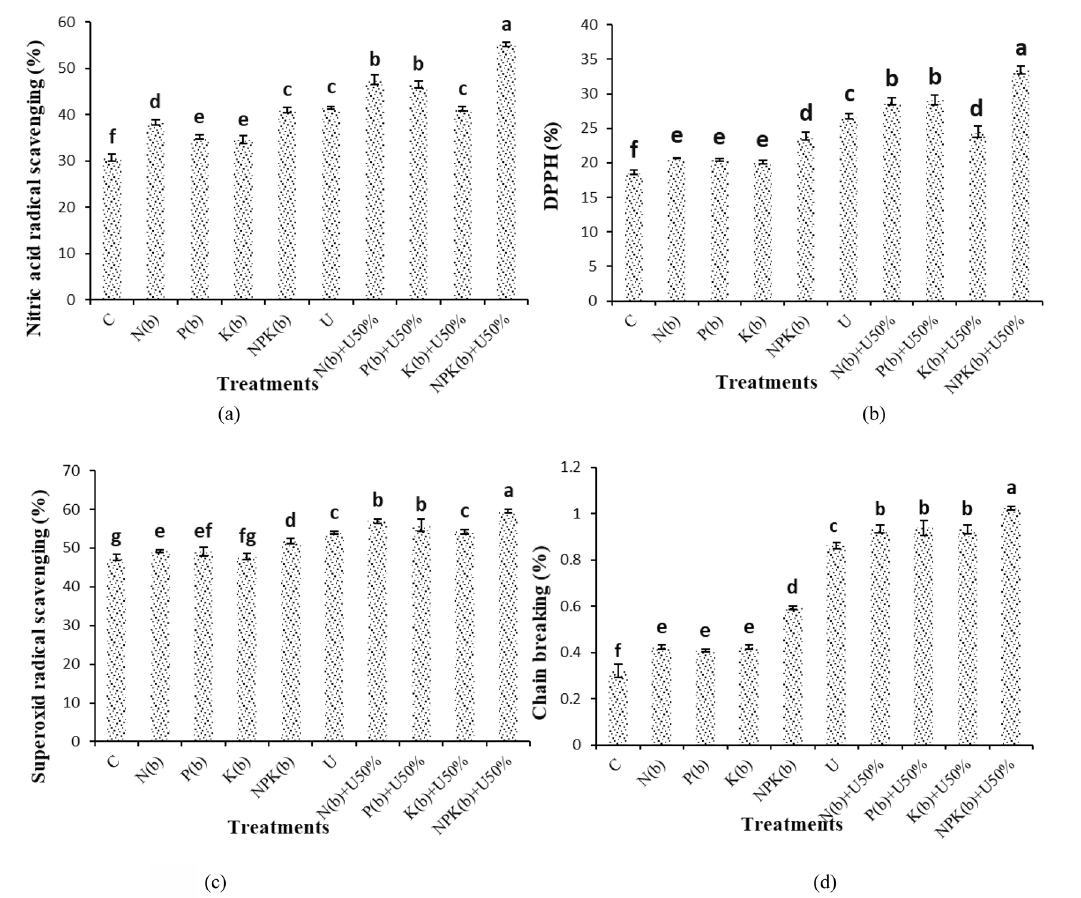
Figure 7. Means comparison for Nitric acid radical scavenging rate, DPPH, Superoxide radical scavenging and Chain breaking activity of Nigella sativa L. as influenced by biofertilizers and urea. Dissimilar letters show significant differences at the p ≤ 0.01 level. Control (C), U Chemical urea, Nb (biological N), Pb (biological P), Kb (biological K, NPKb (mixed biological NPK), Nb + U50%, Pb + U50%, Kb + U50%, and NPKb + and (Pb) + U50% showed 79.60% and 56.35% higher DPPH free radical scavenging rate than the control, respec- tively (Fig. 7b).